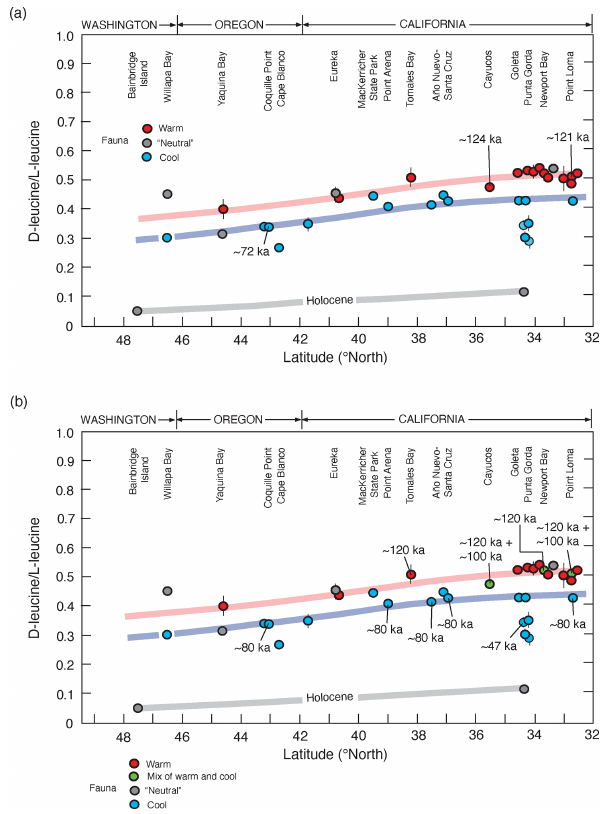
Figure 11. (a) Plot showing D-leucine / L-leucine in fossil Saxido- mus shells (or equivalent values converted from Leukoma staminea shells; see Lajoie et al., 1980) from marine terrace deposits of the Pacific coast of the USA, from Kennedy et al. (1982). Localities are arranged from north (left) to south (right), parallel to latitudi- nal trend of mean annual air temperatures increasing to the south. Samples plotting along the pink line are correlated with MIS 5e ( ∼ 120ka) based on calibration to U-series-dated corals from Cayu- cos and Point Loma; samples plotting along the blue line are corre- lated to MIS 5a ( ∼ 80ka), based on U-series-dated corals from Co- quille Point, Oregon. Calibration points used are the only ones that were available at the time of the original study. Samples plotting below these lines are correlated with MIS 3 or to Holocene-dated deposits (gray line). Not included from the original study are data points from Whidbey Island, Washington, which are interpreted to be from glaciomarine deposits (Polenz et al., 2009). Colors of cir- cles indicate molluscan fauna thermal aspects (see discussion of Fig. 13). (b) Plot of same data as in (a) , except new U-series ages of corals, generated since 1982, have been added and thermal as- pects of some faunas have been modified (Muhs et al., 2002a, 2006,